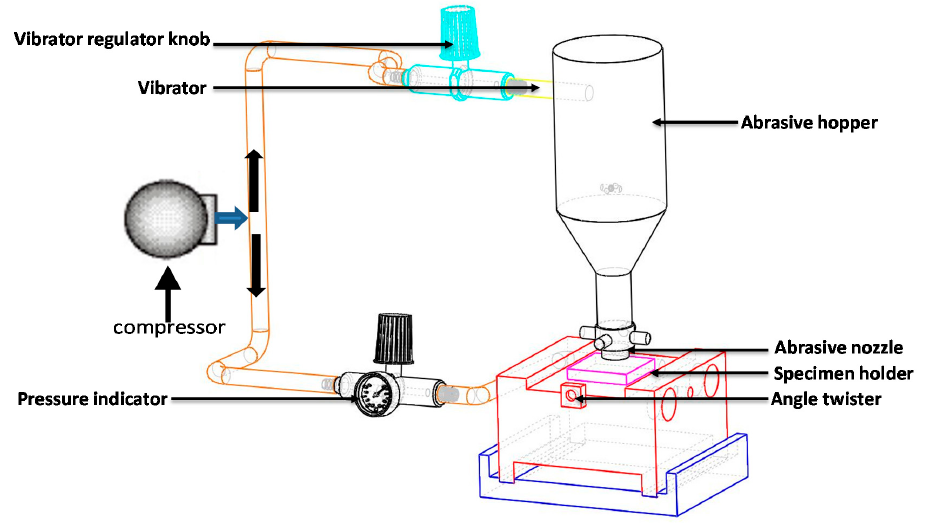
Figure 1. Schematic of the dry erosion machine used to study the erosive behaviour of API X100 steel.